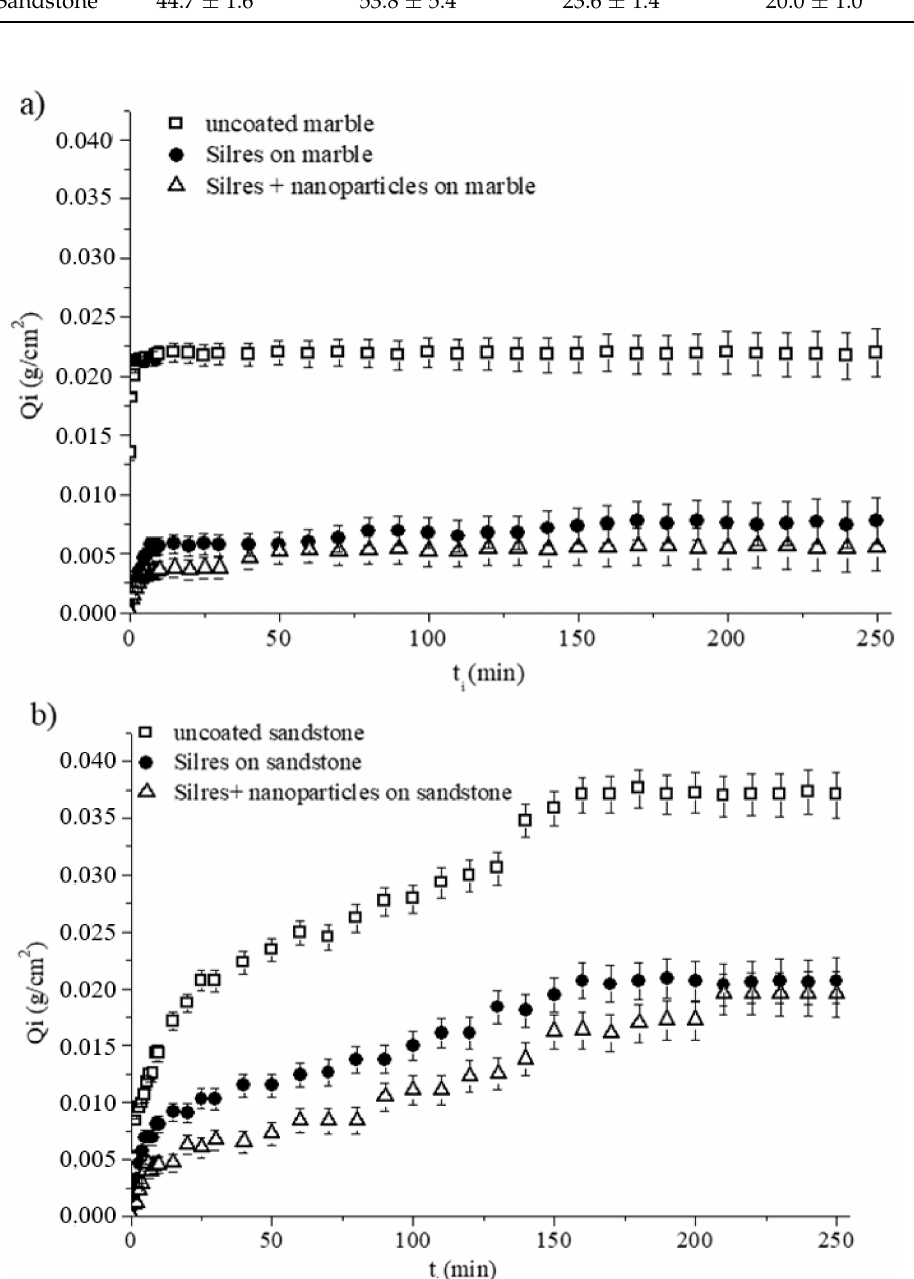
Figure 6. Amounts of absorbed water per unit area (Q i ) as a function of treatment time t i , for ( a ) marble and ( b ) sandstone specimens which were uncoated and coated by Silres and Silres +